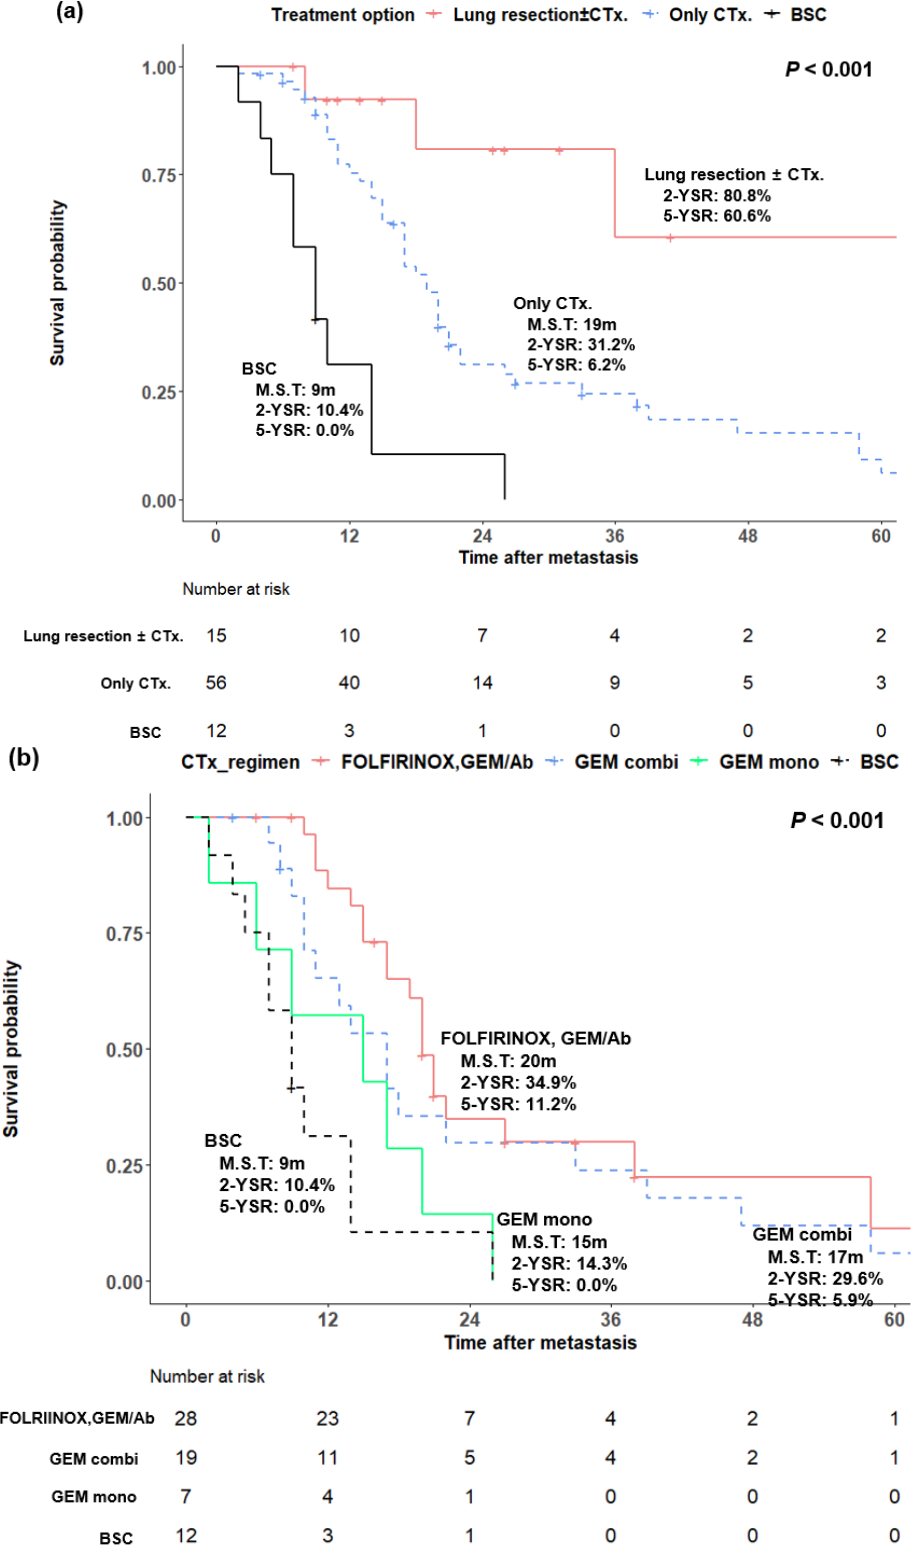
Figure 4. ( a ) Kaplan − Meier analysis of pancreatic ductal adenocarcinoma patients with isolated lung metastasis according to treatment options. ( b ) Kaplan − Meier analysis of pancreatic ductal adenocarcinoma patients with isolated lung metastasis who did not undergo metastatectomy according to a chemotherapy regimen. CTx., chemotherapy; BSC, best supportive care; M.S.T., median survival